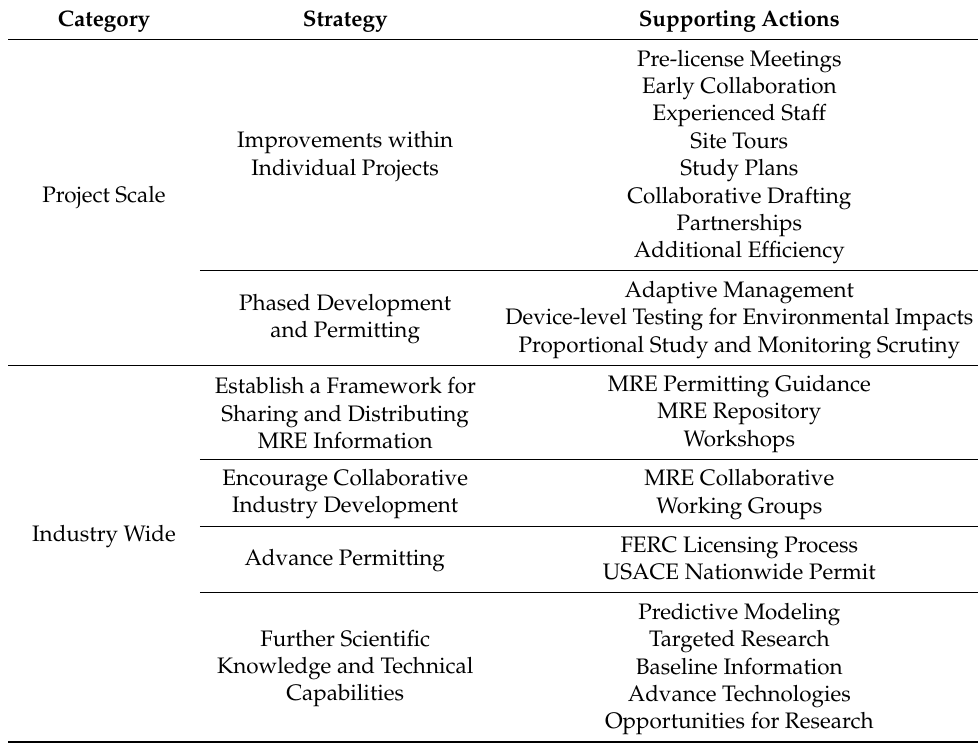
Table 1. Strategies and Actions to increase the efficiency and effectiveness of permitting and licensing of MRE